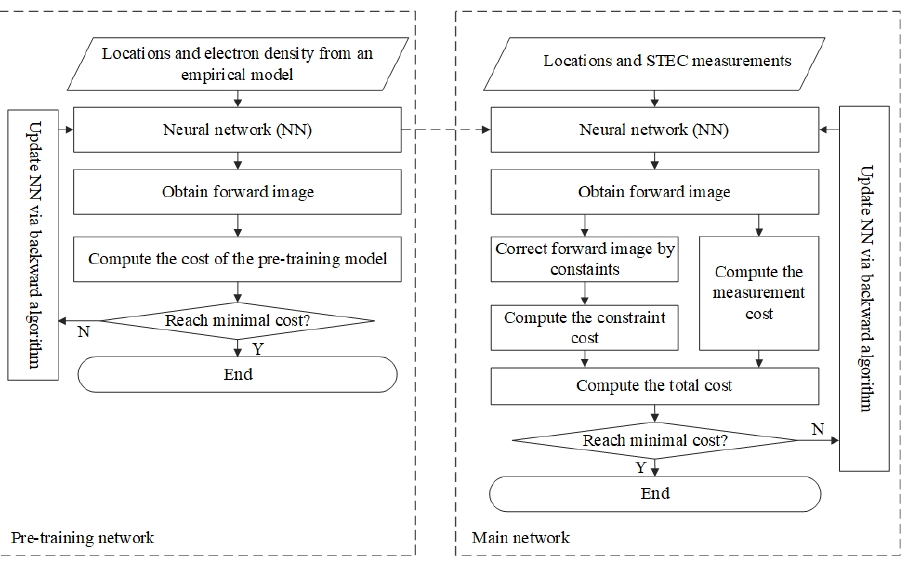
Figure 1. Basic flows to implement the BCDC